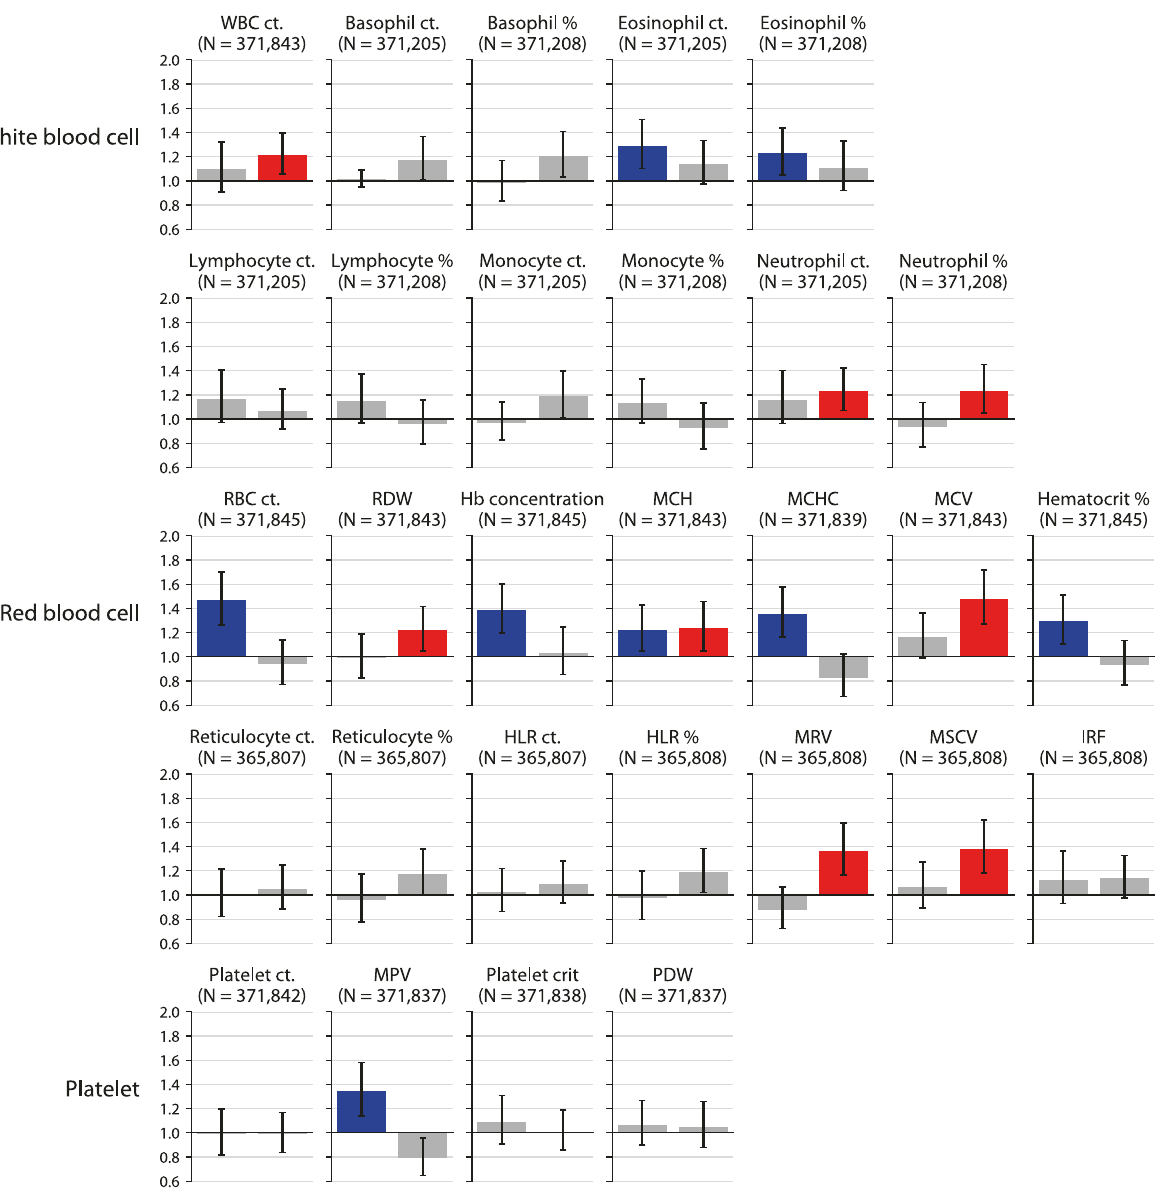
Fig. 2 Association of blood counts with 5-year MDD incidence. Adjusted odds ratios of 5-year MDD incidence among individuals in the bottom 2.5% (left) or top 2.5% (right) of each blood test, after correcting for demographic, temporal, socioeconomic, and lifestyle factors. Signi fi cant associations at 5% FDR are denoted in blue (bottom 2.5%) or red (top 2.5%). Error bars denote 95% con fi dence intervals. ct. count; other abbreviations are de fi ned in Table